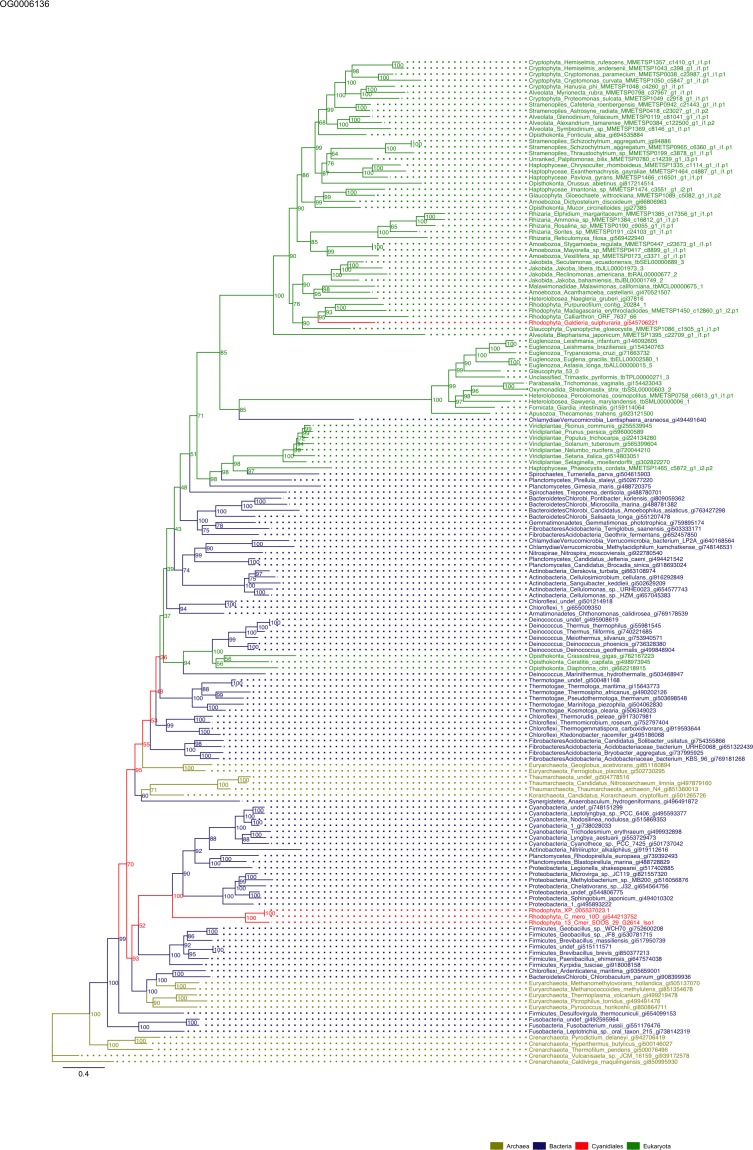
Sequence tree of orthogroup OG0006136.The tree is based on amino acid sequences. Archaea (yellow), Bacteria (blue), Cyanidiales (red), Eukaryotes including other red algae (green). Branches containing Cyanidiales sequences are highlited in red.